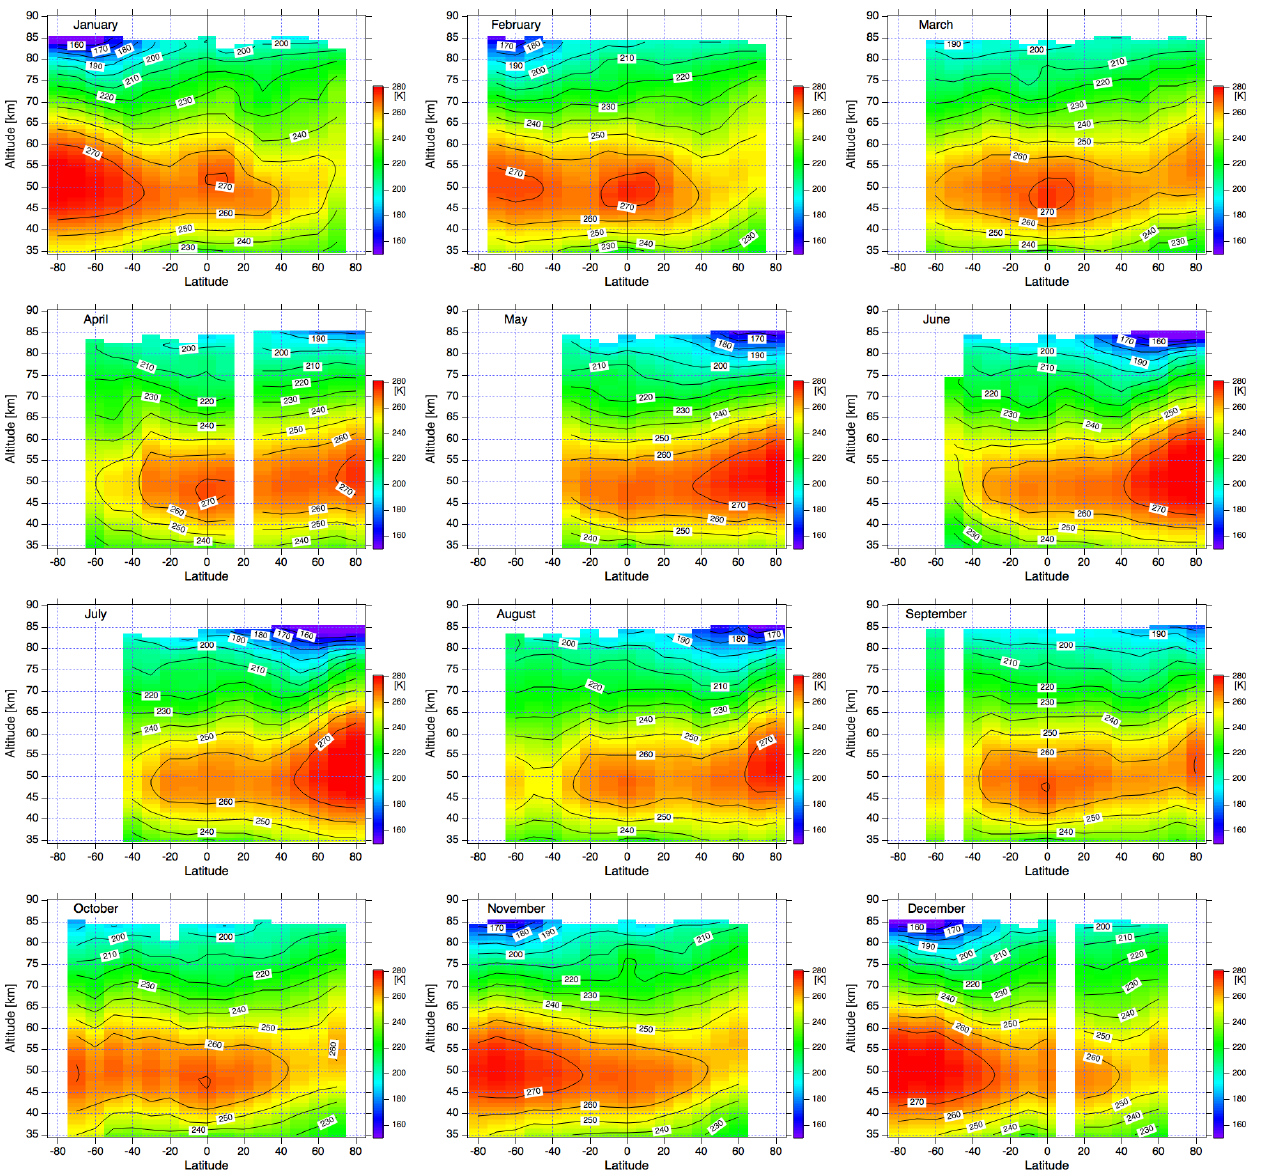
Figure 6. Monthly climatology of GOMOS Rayleigh temperature. The data are averaged over 10 ◦ latitude